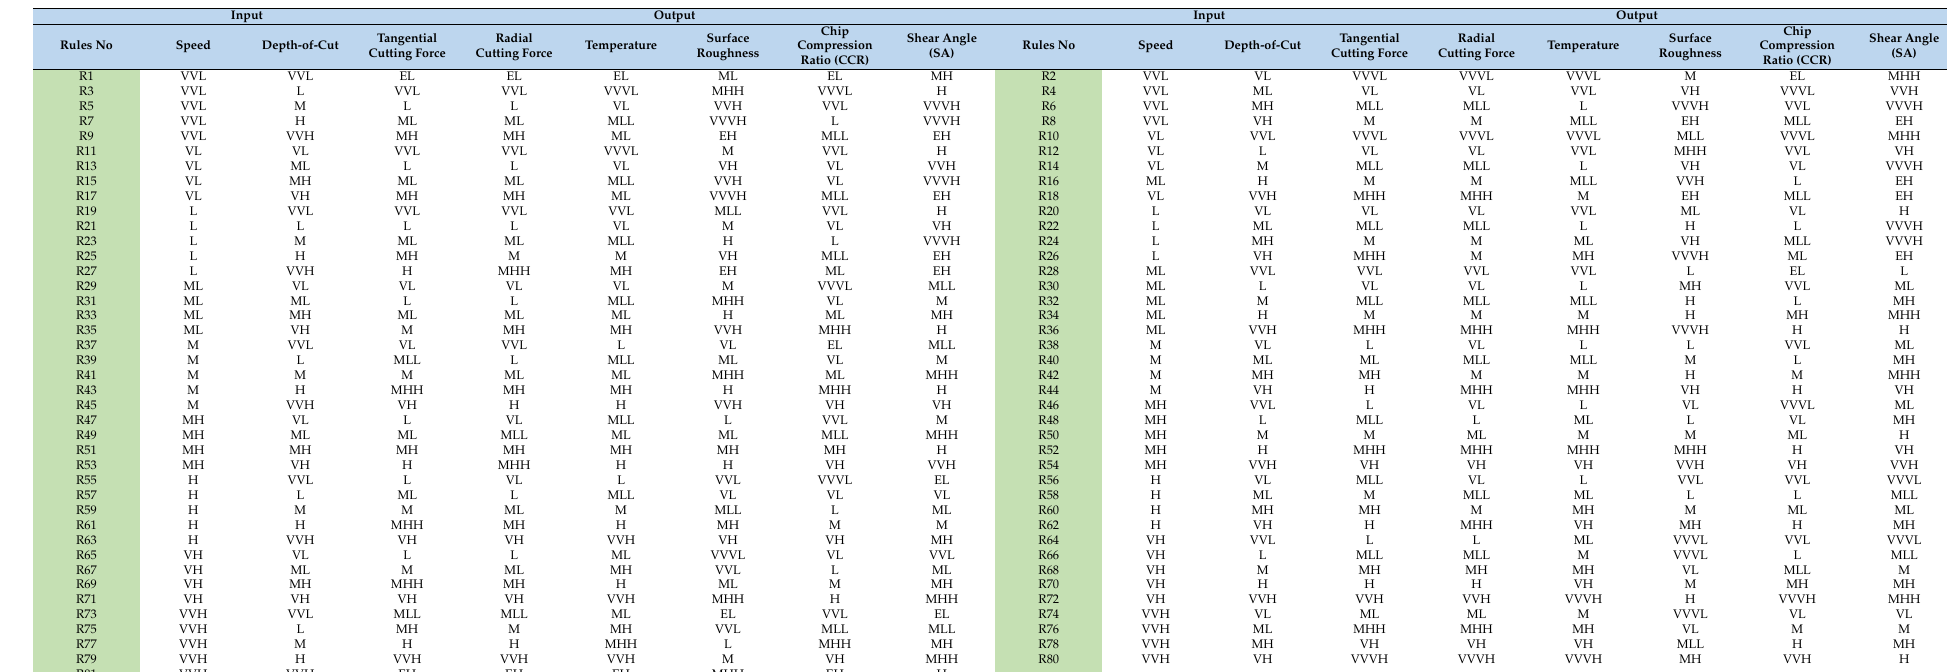
Table 4. The rules used in the UVAT